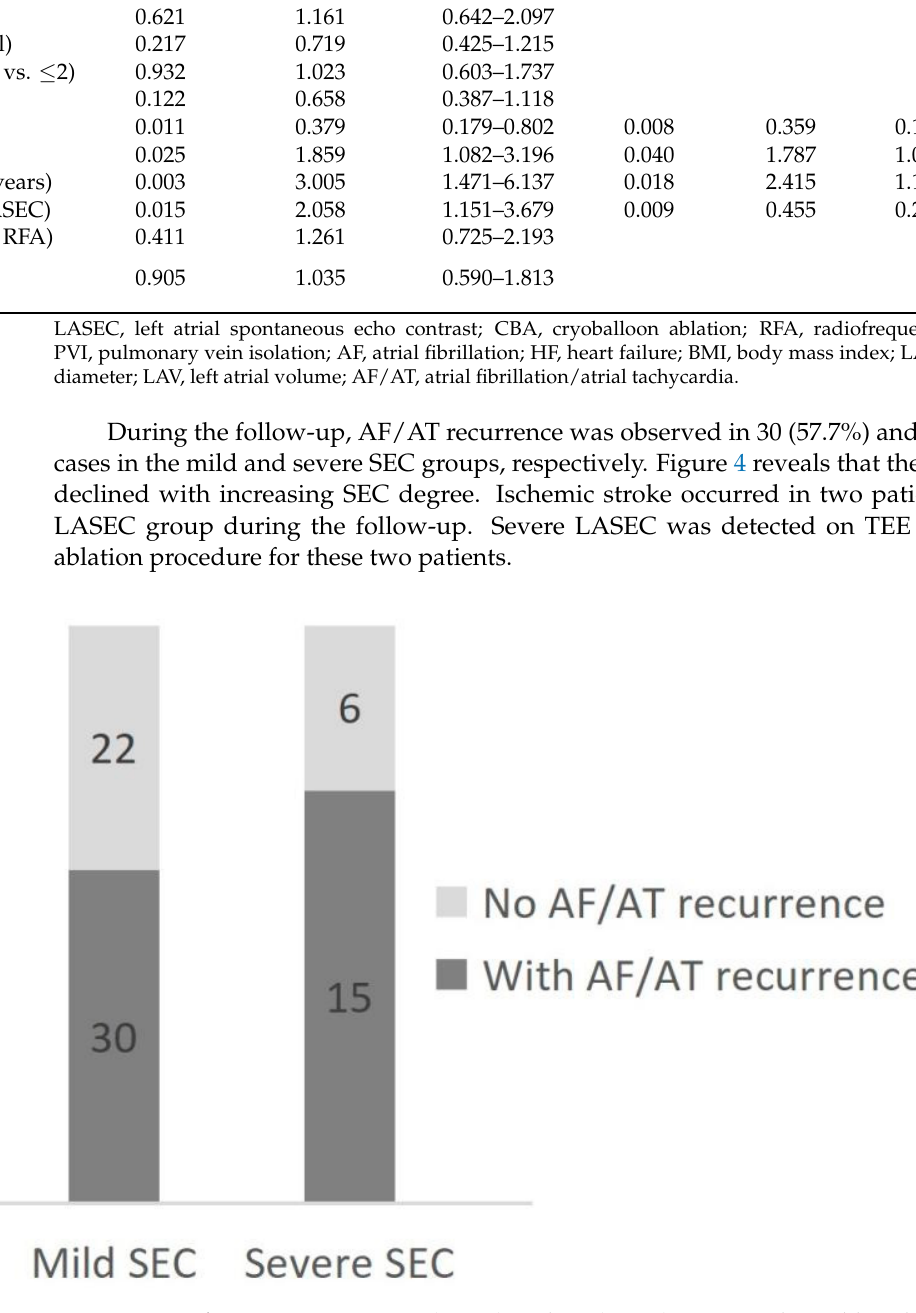
Figure 4. AF/AT recurrence in 30 (57.7%) and 15 (71.4%) cases in the mild and severe SEC groups, respectively.